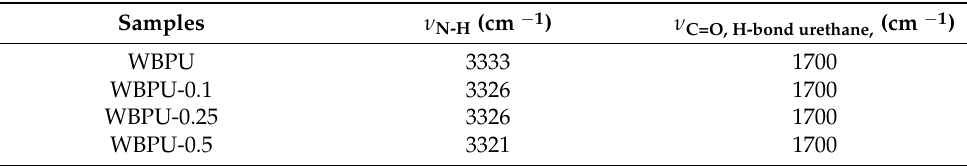
Table 3. Characteristic vibrational band influence by addition of CNF.